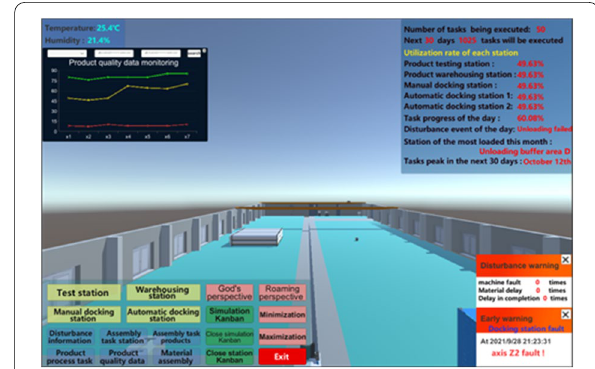
Figure 12 Assembly quality monitoring diagram of the assembly shop-floor based on the DT